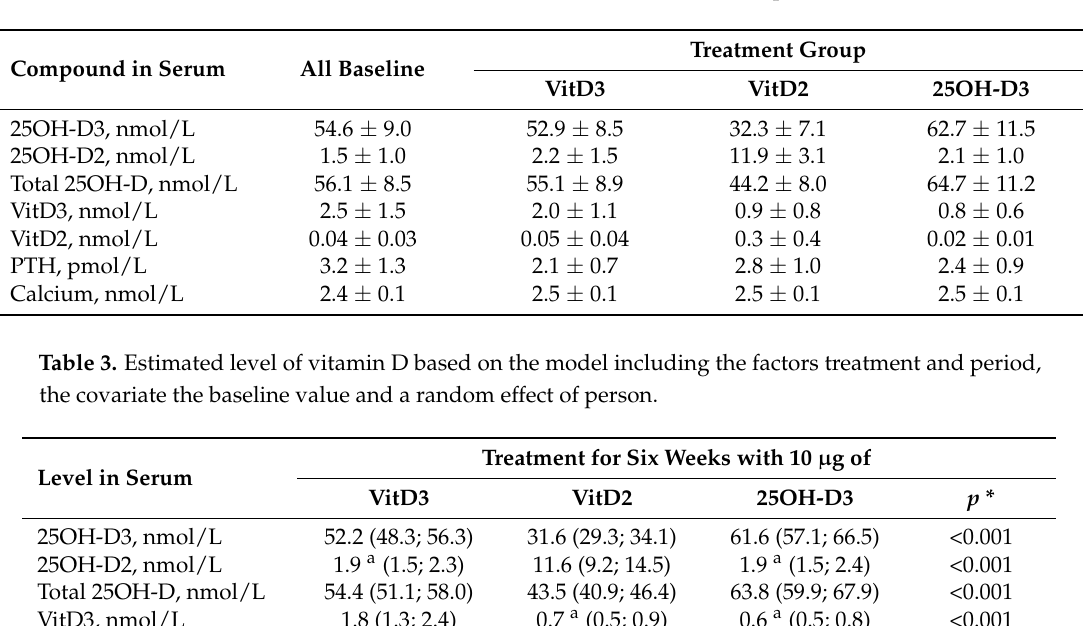
Table 2. Observed serum levels at baseline and after each treatment period (mean ± SD).